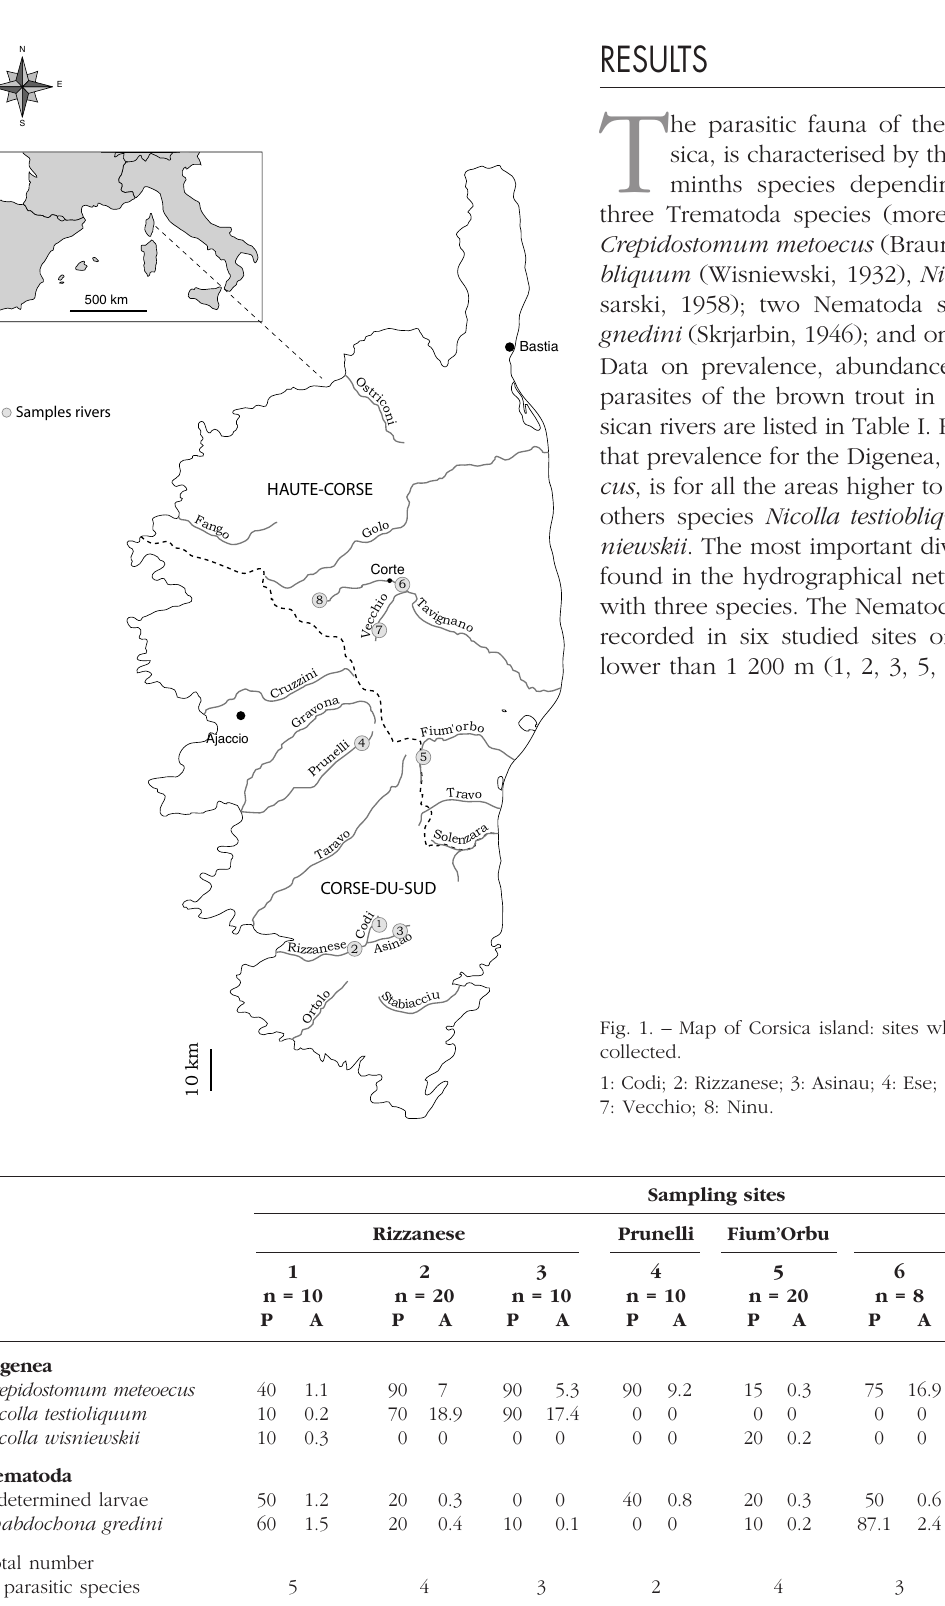
Table I. – Prevalence and abundance of Salmo trutta parasites in different sites of